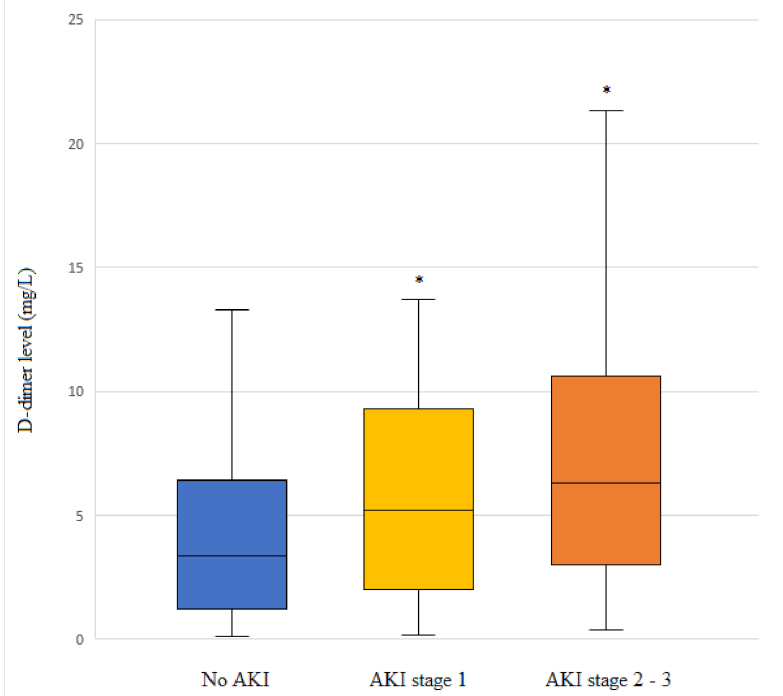
Figure 2. D-dimer levels according to acute kidney injury (AKI) stage in patients undergoing living- donor liver transplantation (LDLT). Box plots show the median (line in the middle of the box), interquartile range (box), and 5th and 95th percentiles (whiskers). * p < 0.001 vs. no